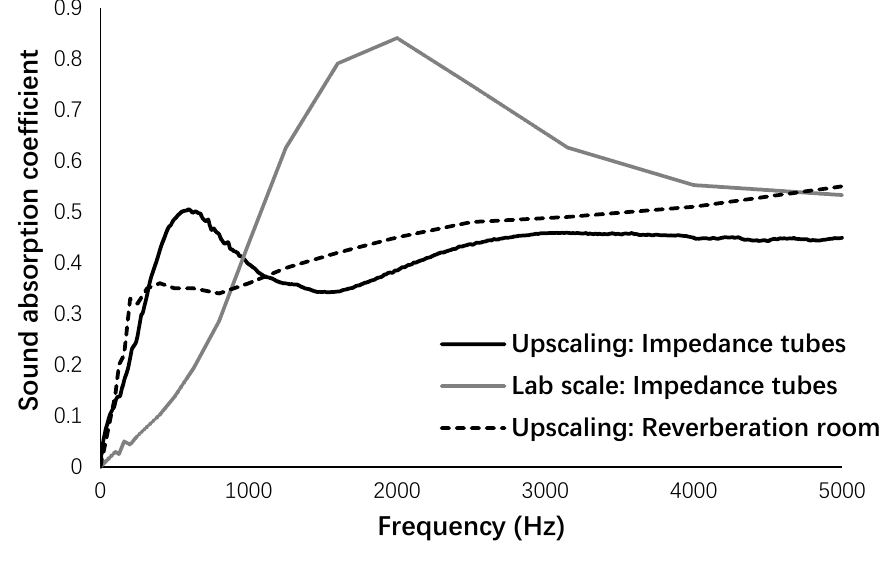
Figure 17. A comparative assessment of sound absorption.